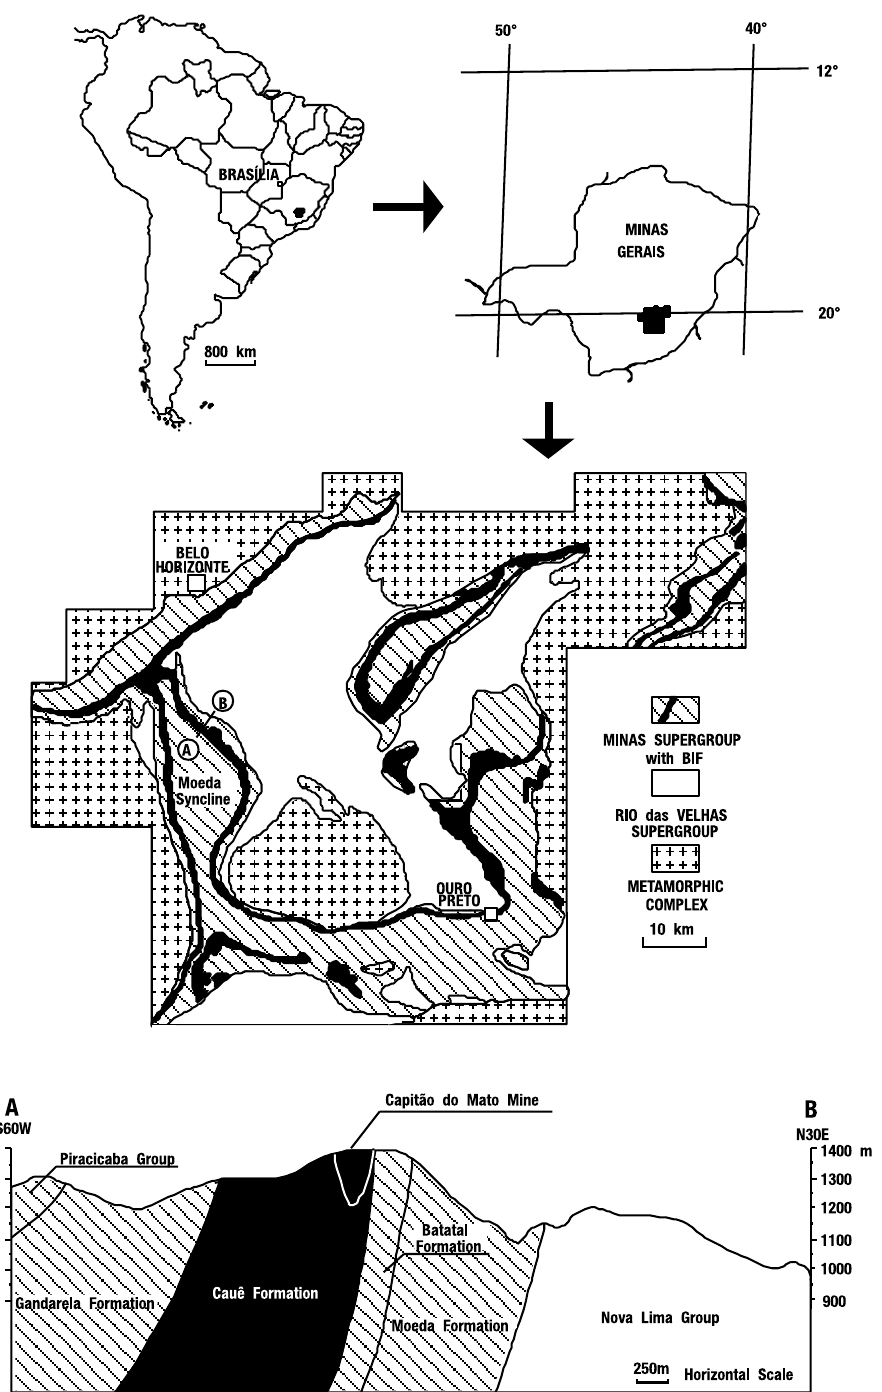
Fig. 1 – Location, geologic map (Marshak and Alkmim, 1989) and geologic section of the Capitão do Mato Mine (geology from Pomerene 1964), Iron Quadrangle, Minas Gerais State, Brazil.